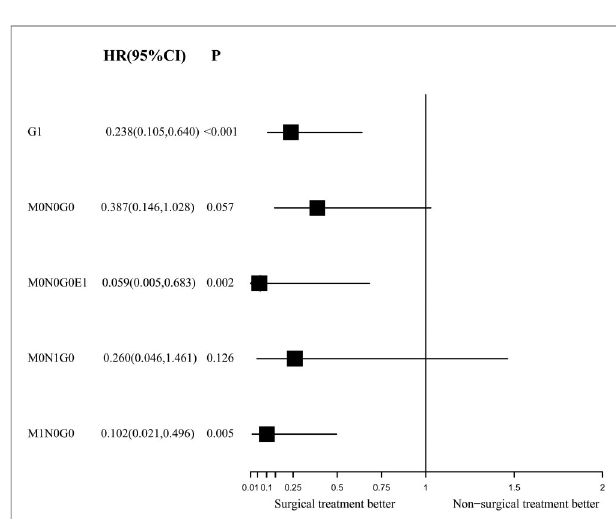
FIGURE 6 | Forest plot depicting inverse probability of treatment weighting – adjusted hazard ratios of cancer-speci fi c mortality in different subgroups of surgery versus non-surgery. The multivariable model was constructed with pre-speci fi ed variables (surgery, sex, age) to avoid over fi tting, considering the limited number of